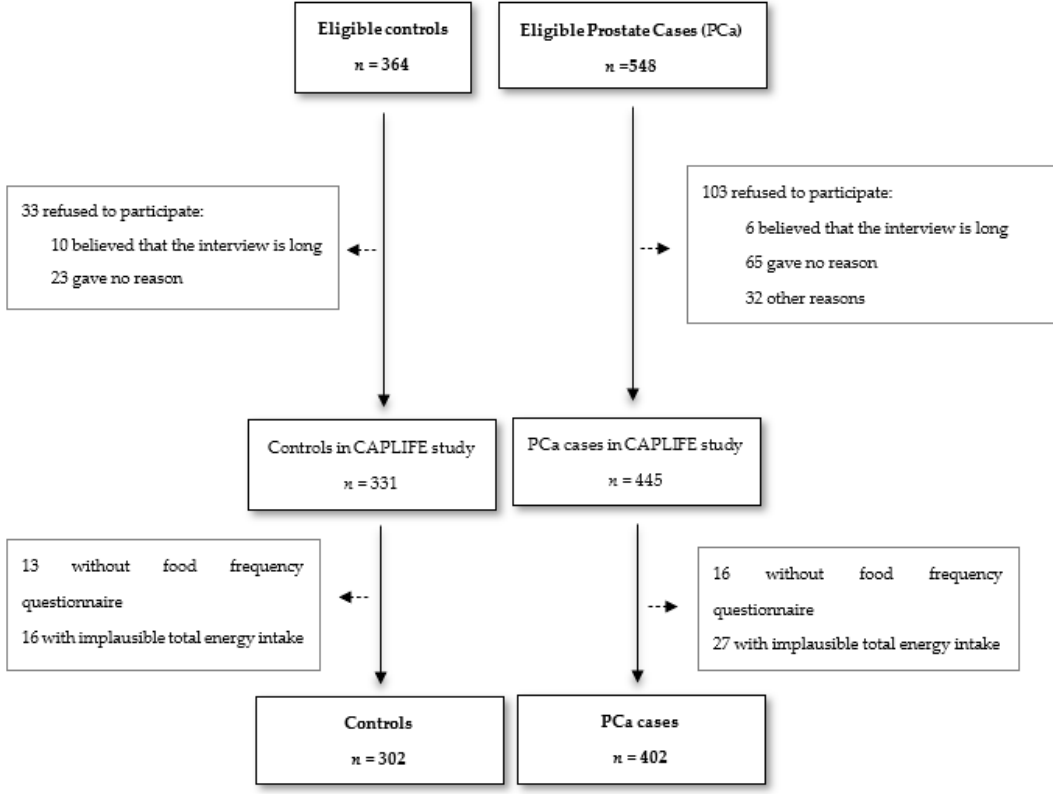
Figure 1. Flow-chart CAPLIFE (CAP: prostate cancer; LIFE: lifestyles) study.